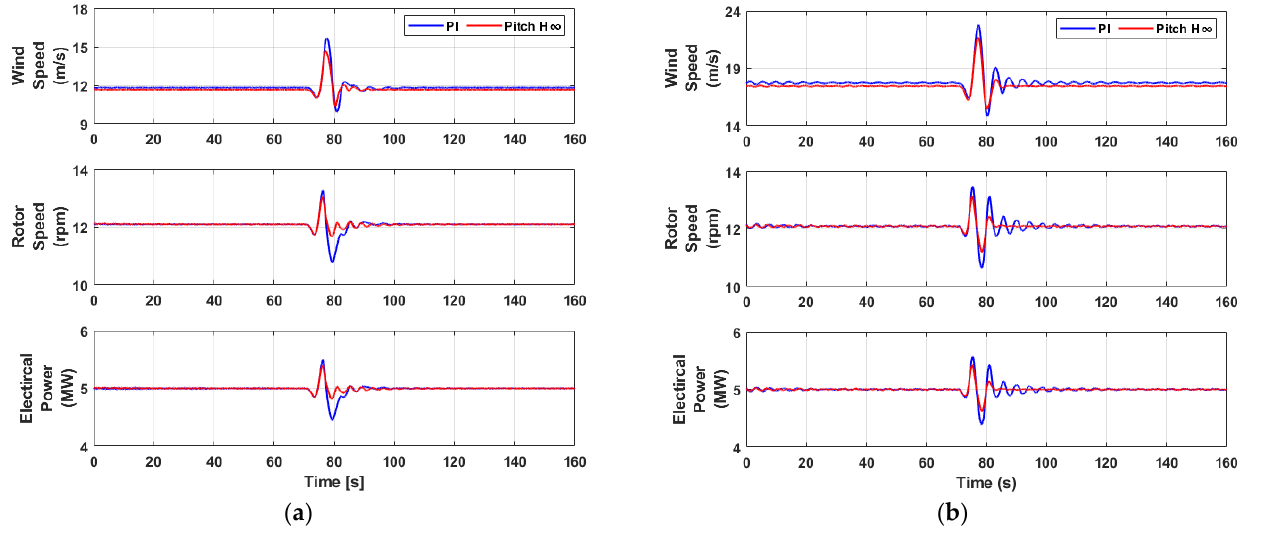
Figure 13. EOG results in noiseless environments. ( a ) Wind speed of 12 m/s; ( b ) wind speed of 18 m/s. Table 6. Comparison of EOG results for performance data in 12 m/s noiseless environment. Perfor-